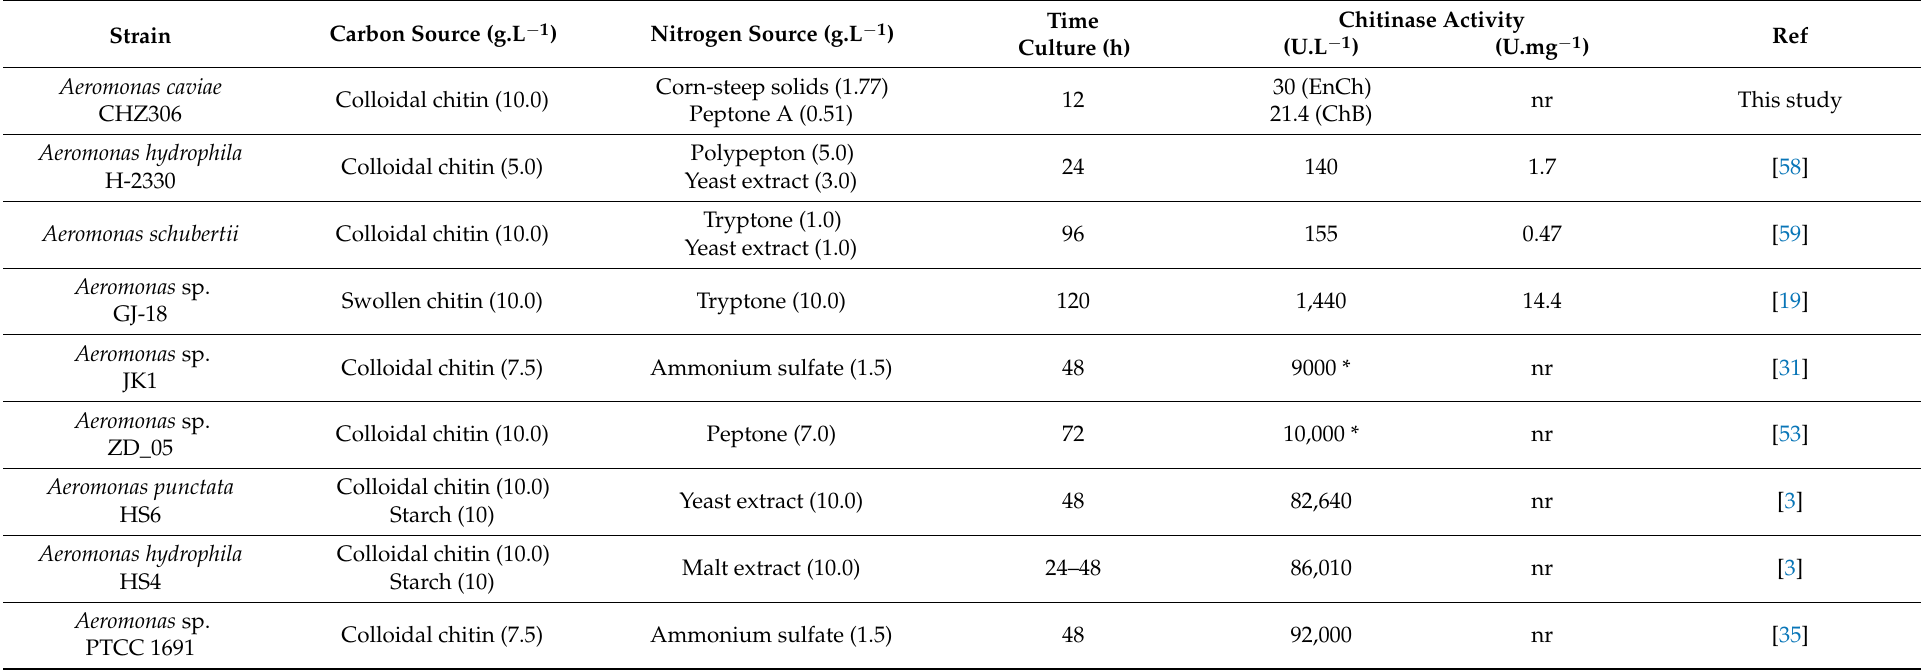
Table 3. Comparative reports of chitinase production by Aeromonas